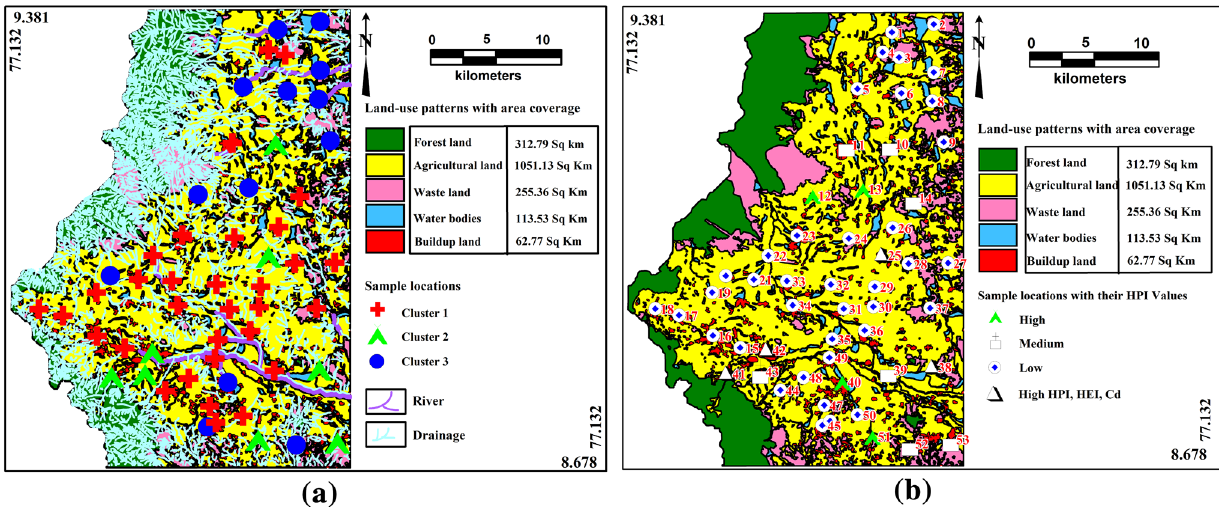
Fig. 4 a Land-use and drainage map along with the sample locations of the 3 clusters, b land-use pattern and sample locations with their HPI values, c dendrogram obtained by cluster analysis using